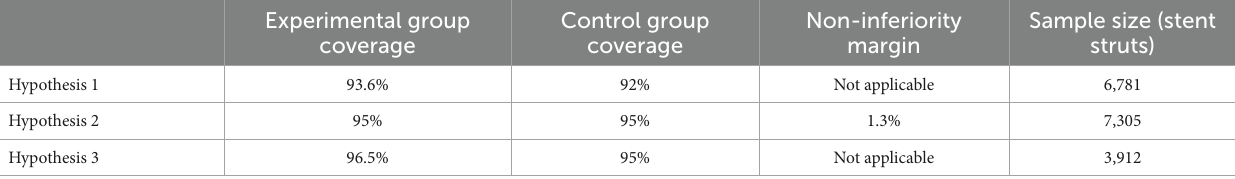
TABLE 4 Parametric assumptions for hypothesis.